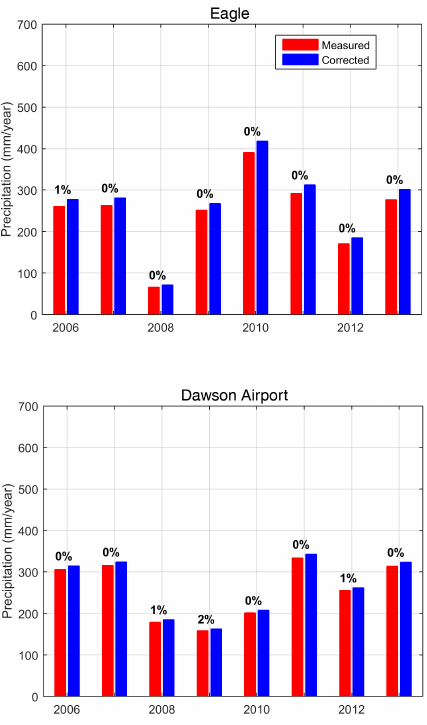
Figure 8. Annual precipitations during 2006–2013 for two stations in the central part of the AK–YK border. The percentages above the bars represent the missing data for the corresponding year.